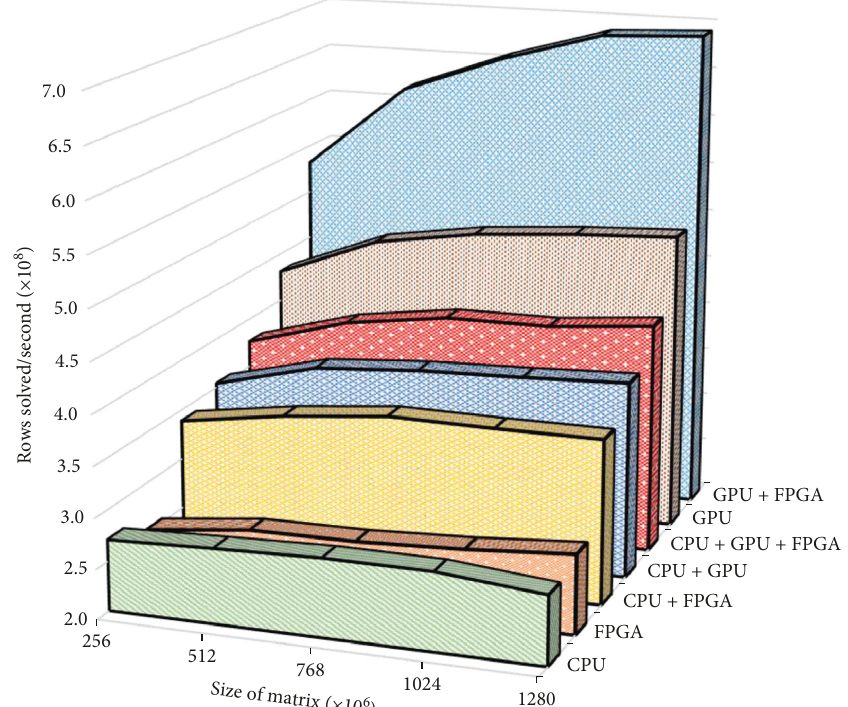
Figure 8: Performance comparison in rows solved per second for N � ( 256 .. . 1280 ) × 10 6 when targeting CPU, GPU, FPGA, and heterogeneous combinations of devices.